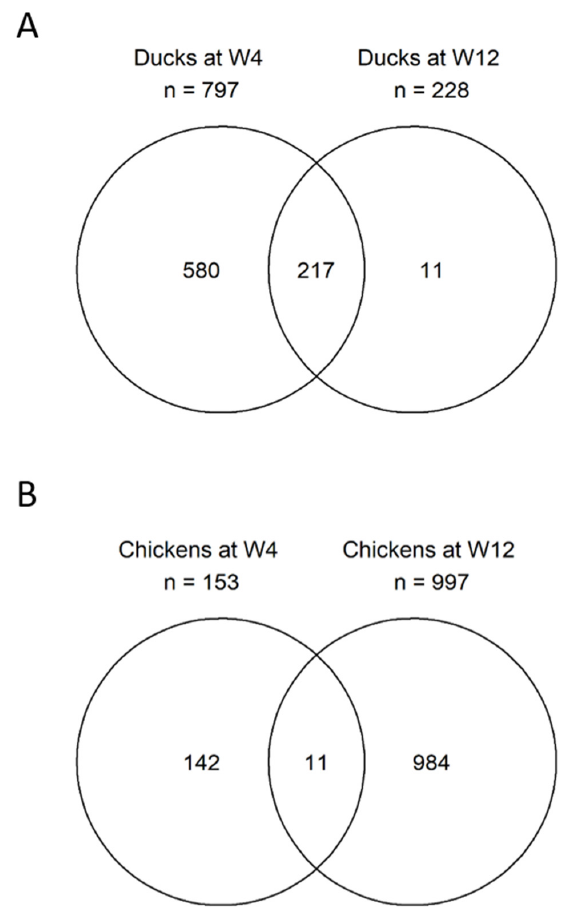
Figure 3. Venn diagram showing proportions of highly differentially expressed genes (hDEGs) between 4 and 12 weeks post-infection (wpi), in both Muscovy ducks and chickens. In ( A ), hDEGs in the brains of ABBV-1-infected Muscovy ducks at 4 wpi were compared with those at 12 wpi. The majority of hDEGs occurred at 4 wpi, and 217 hDEGs were shared between 4 and 12 wpi. In ( B ), the hDEGs in the brains of ABBV-1-infected chickens at 4 wpi were compared with those at 12 wpi. The majority of hDEGs occurred at 12 wpi, and only 11 hDEGs were shared between the two time points. In summary, there were differences in the global differential gene-expression pat- terns of the duck and chicken brains in response to ABBV-1 infection, mostly in association with the degree of encephalitis. For the ducks, the number of tDEGs and hDEGs was high- est at 4 wpi, when inflammation was high, and decreased at 12 wpi, when lower inflam- mation-severity scores were registered. Regardless of the time point, most of the hDEGs were upregulated in the ducks. For the chickens, this difference was noted mainly for the hDEGs, which dramatically increased from 4 wpi, when no inflammation was detected, to 12 wpi, the time of high inflammation. Notably, the majority of the tDEGs (58.5%) and hDEGs (94.8%) were downregulated in the chickens at 4 wpi, when infection was estab- lished, but inflammation was not detected. 3.4. Highest-Ranking hDEGs (|log 2 FC| > 2) in Duck and Chicken Brains in Response to ABBV-1 Infection Are Associated with Immune Functions, Regulation of Gene Expression, and the Cell-Membrane Location We further examined the 20 highest-ranking known and unknown (novel) hDEGs in the duck and chicken brains at 4 and 12 wpi. The known genes, along with their descrip- tions (as provided in the Ensembl database), are reported in Tables 3 and 4; the unknown